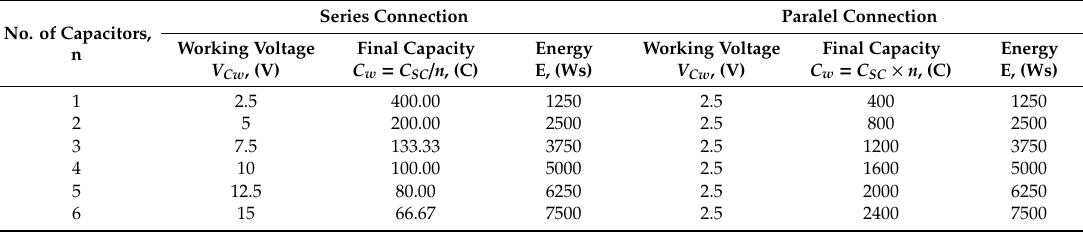
Table 2. Selected electrical parameters for various supercapacitor configurations in series and in